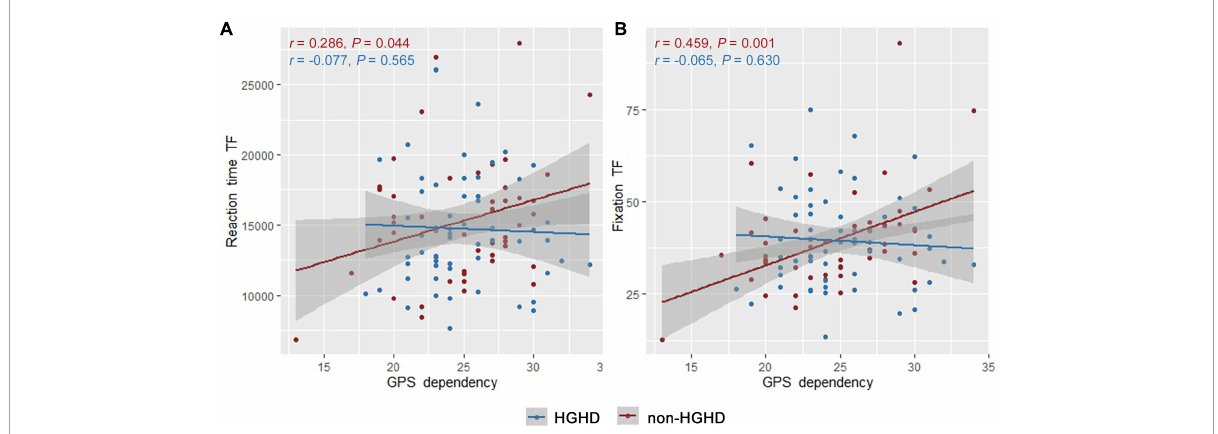
FIGURE6 Correlation between GPS dependency and indicators in eye-tracking TF task in subgroup stratified by Internet gaming behavior. (A) Reaction time; (B) fixation. TF represents target finding task. HGHD represents high gaming hours daily